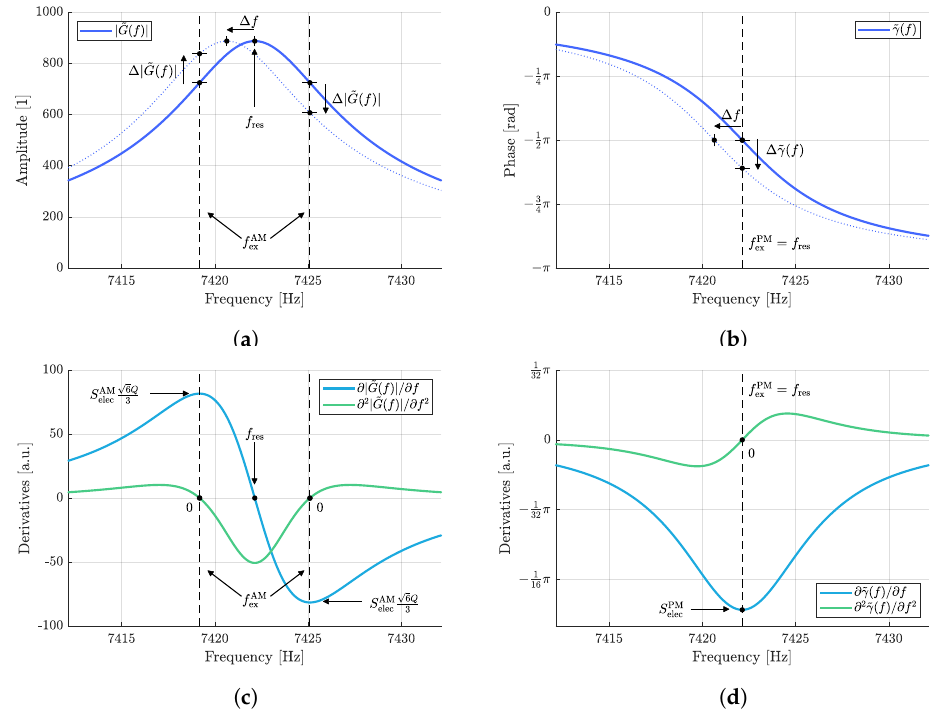
Figure 4. Illustration of the relations between shifted amplitude ( a ) and phase ( b ) frequency re- sponses due to a detuned resonance frequency and the corresponding electrical sensitivities. Highest sensitivities are given by the corresponding first derivative at those frequencies at which the second derivatives are zero ( c , d ). These frequencies are referred to as the optimum excitation frequencies. The plots are based on the sensor parameters specified in Table